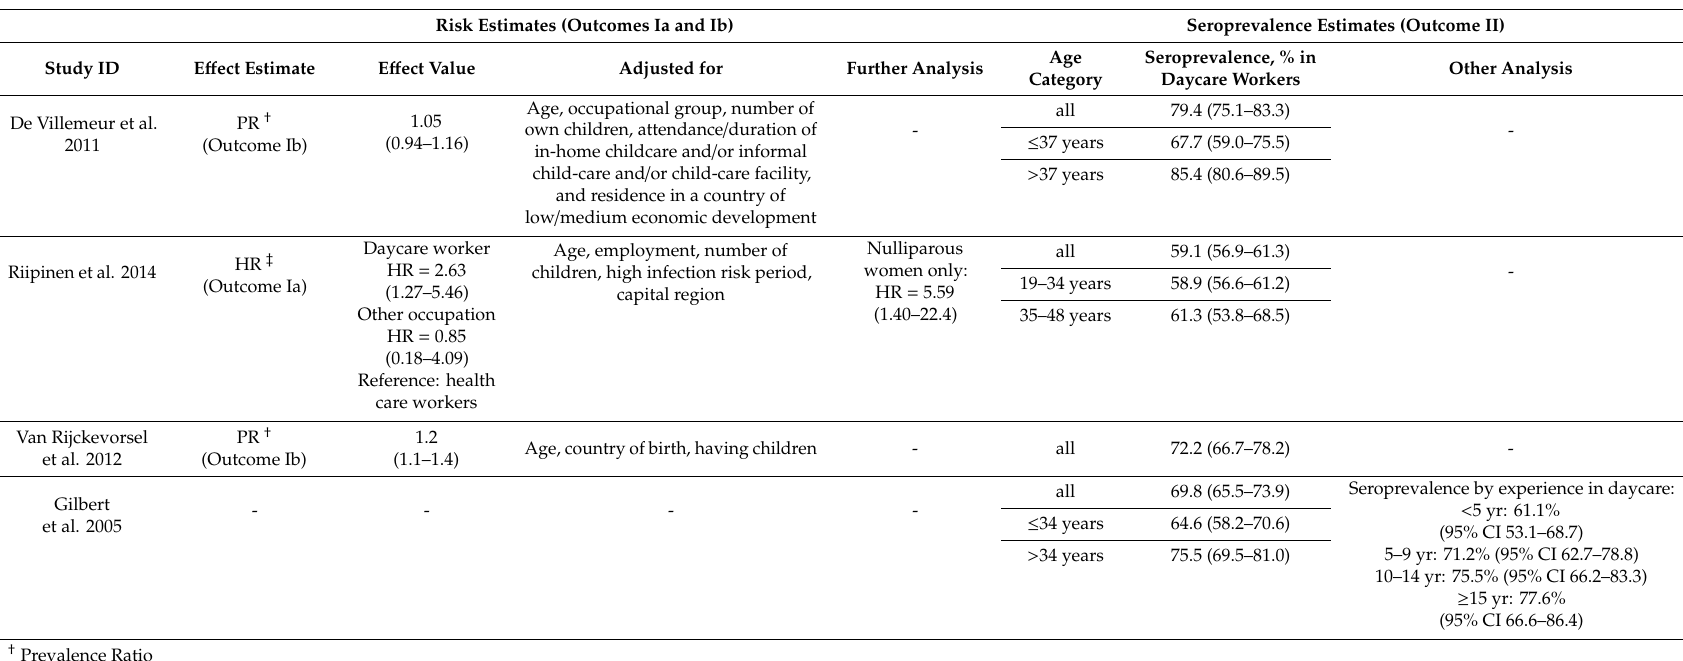
Table 2. The summary of the parvovirus B19 seroprevalence and risk estimates for daycare